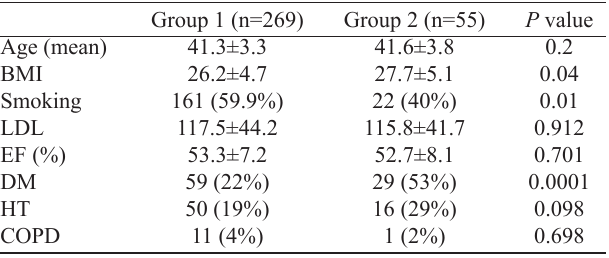
Table 1. Demographic data of the groups and distribution of the risk factors.